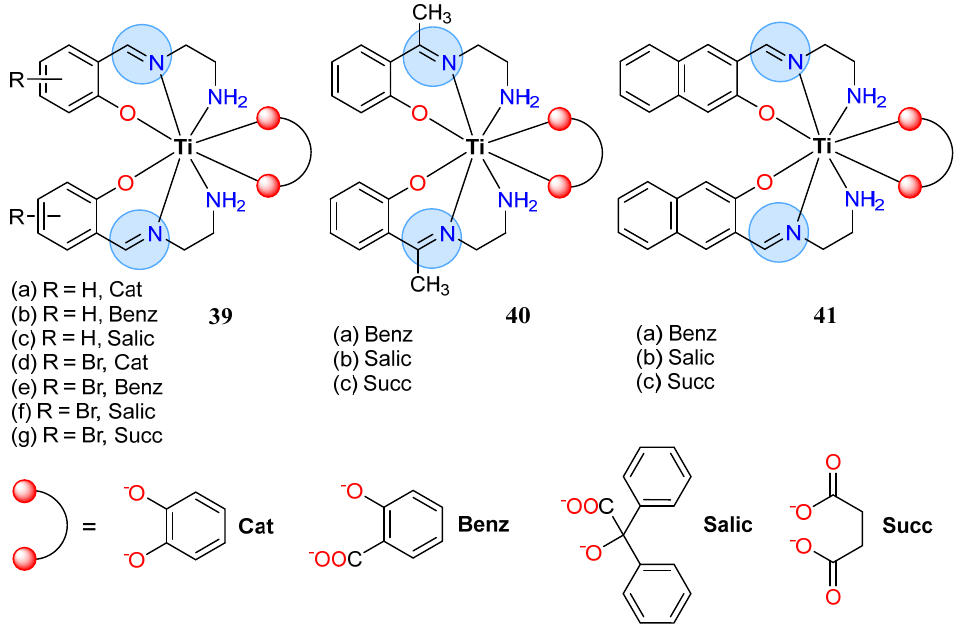
Figure 17. Ti(IV) complexes with Schiff Bases derived from aroylhydrazine with antimicrobial and antioxidant properties.